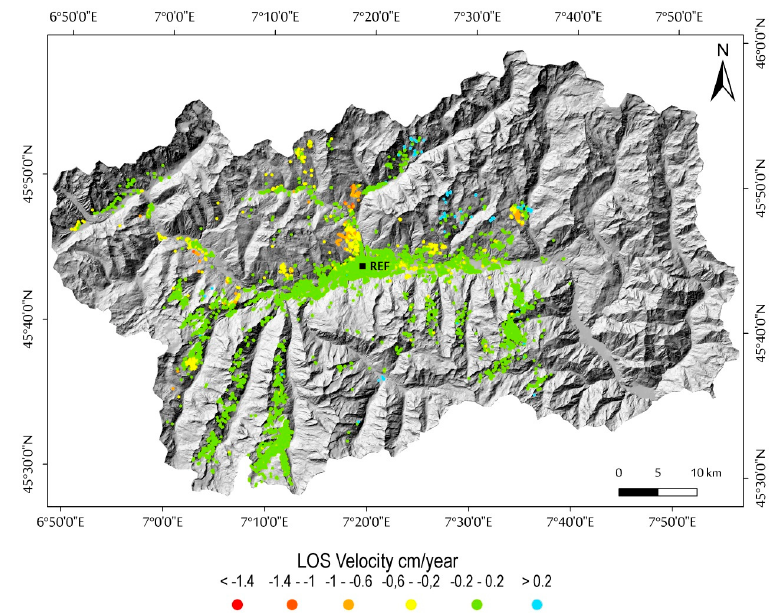
Figure 7. Surface velocities measured along the satellite LOS for the ERS-1/2 dataset in ascending orbit for the time period from June 1995 to May 2000. The light blue polygons correspond to the present glaciers.